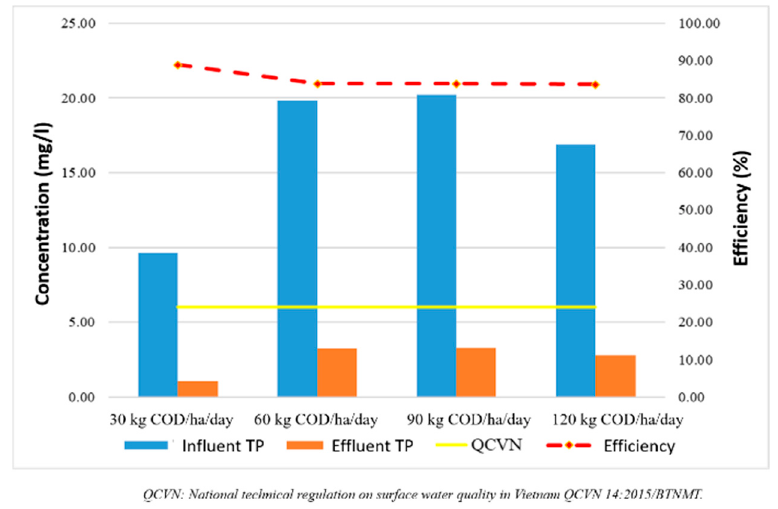
Figure 3. Effect of organic loading on Phosphorous Total removal efficiency.